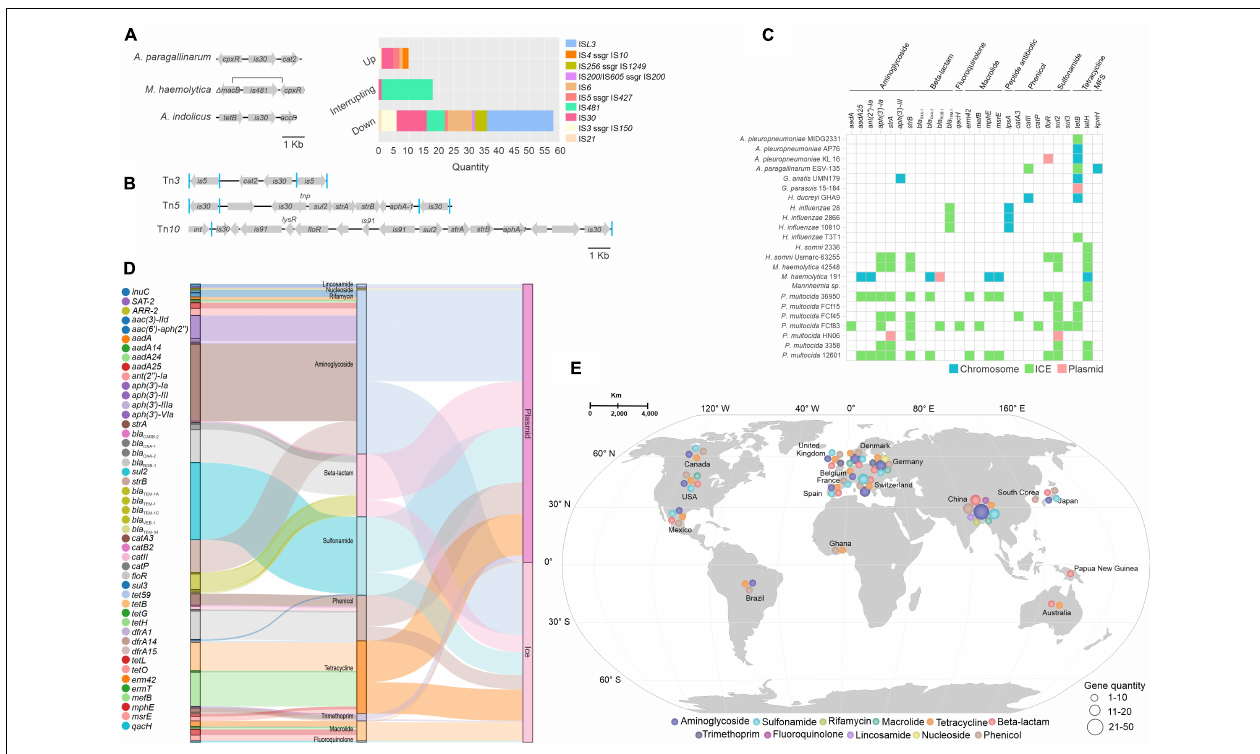
FIGURE 6 | Mobile genetic elements (MGEs) role in dissemination of antimicrobial resistance (AMR) genes. (A) Three representative ISs and AMR gene contexts found in this study. Figure highlights, in order, ISs from three different species (genomes) upstream, interrupting, and downstream of AMR genes. The bar graph (top-left graph) shows the values from the previous context for ten IS families. (B) Representation of the Tn 3 , Tn 5 , and Tn 10 transposon families carrying AMR genes. Squares in blue identify direct repeats of the IS elements. The name of the AMR gene is shown inside the arrows. (C) Comparison of MGEs (green and pink) and their host genomes (in blue) carrying AMR genes. The name of AMR genes and their classes are shown at the top of the table. (D) Sankey diagram representing the diversity of AMR genes and their classes; the distribution of these genes between plasmids and ICEs. (E) Geographic distribution of AMR classes found within MGEs, color-coded as to their AMR classes. The scale below the map indicates the quantity of AMR genes found for each